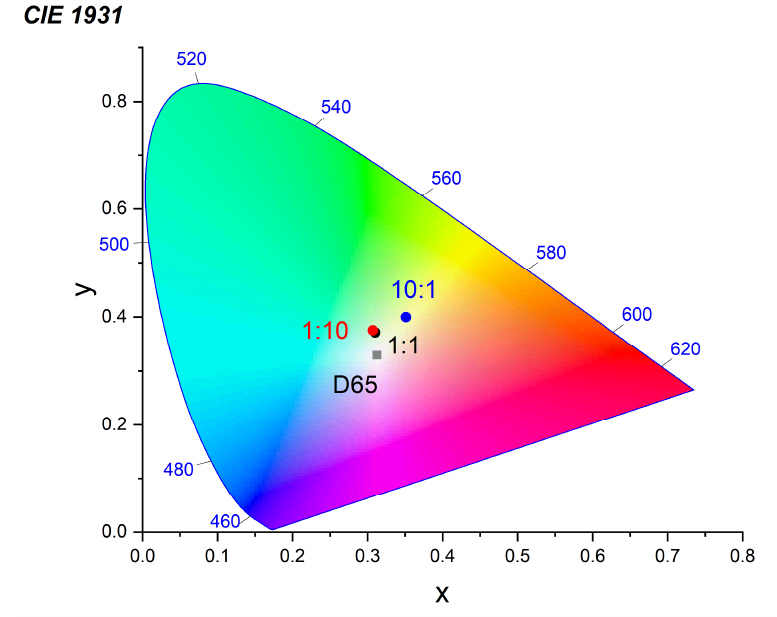
Figure 5. Chromatic diagram of the QD–p99 composite films with different QD-to-polymer mass ratios.